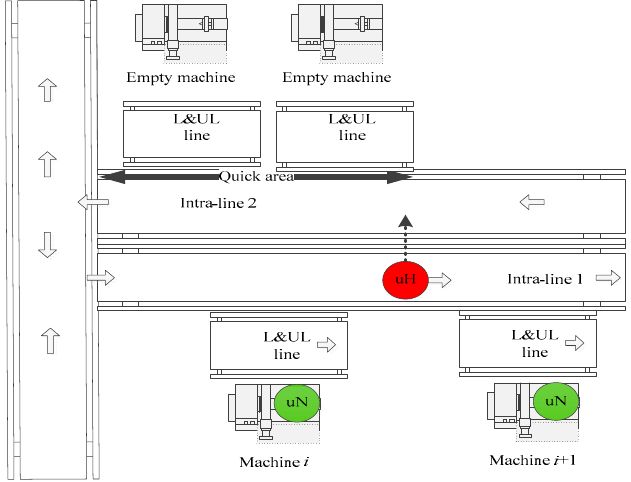
Figure 8. Directly move an uH to Intra-Line 1 from Intra-Line 2 (Rule 4).